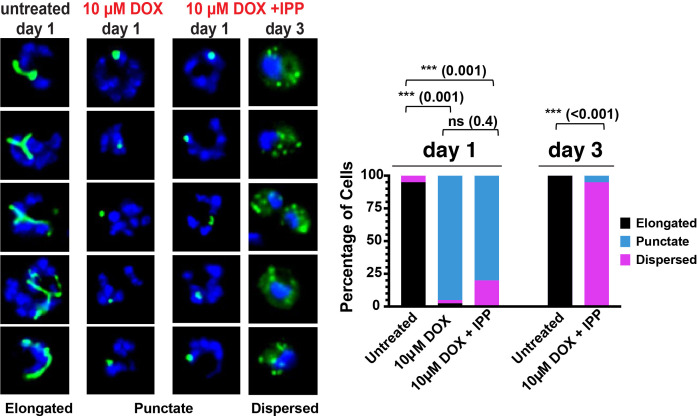
Additional epifluorescence images of DOX-treated D10 parasites.Magnet plus sorbitol-synchronized parasites were treated as rings with 10 µM DOX ±200 µM IPP and imaged 1 or 3 days later (green = ACPL GFP, blue = nuclear Hoechst stain). Twenty to 40 total parasites were examined for each treatment condition on each given day for duplicate experiments, and data were plotted as the average percentage of parasites in each population that displayed an elongated, punctate, or dispersed apicoplast GFP signal. For clarity, error bars are not displayed but standard errors of the mean were ≤15% in all conditions. Cell-percentage differences were analyzed by two-tailed unpaired t-test (p values in parentheses, ns = not significant).